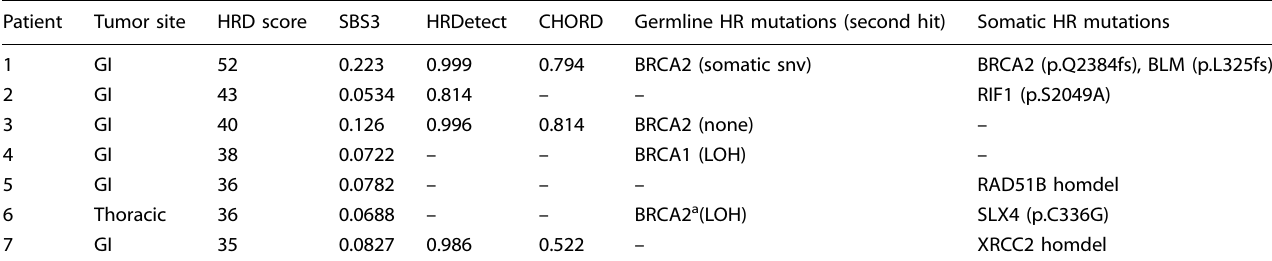
Table 2. DNA repair mutations among patients with both high HRD and high SBS3 scores. For tumors that were classi fi ed as HRD by HRDetect or CHORD, the scores are indicated.